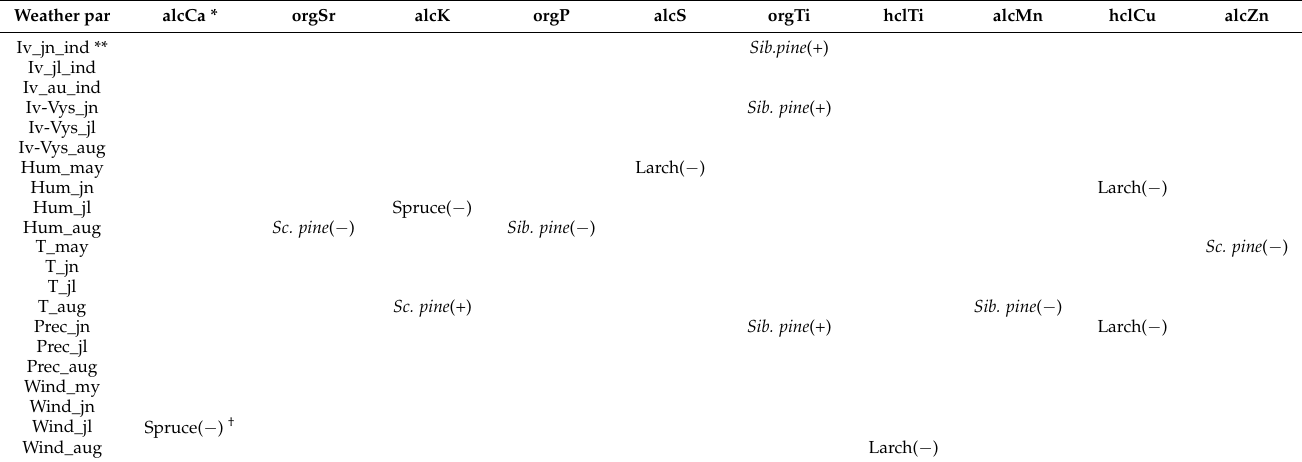
Table 1. Consistent correlations for the conifer species according to Spearman rho correlation